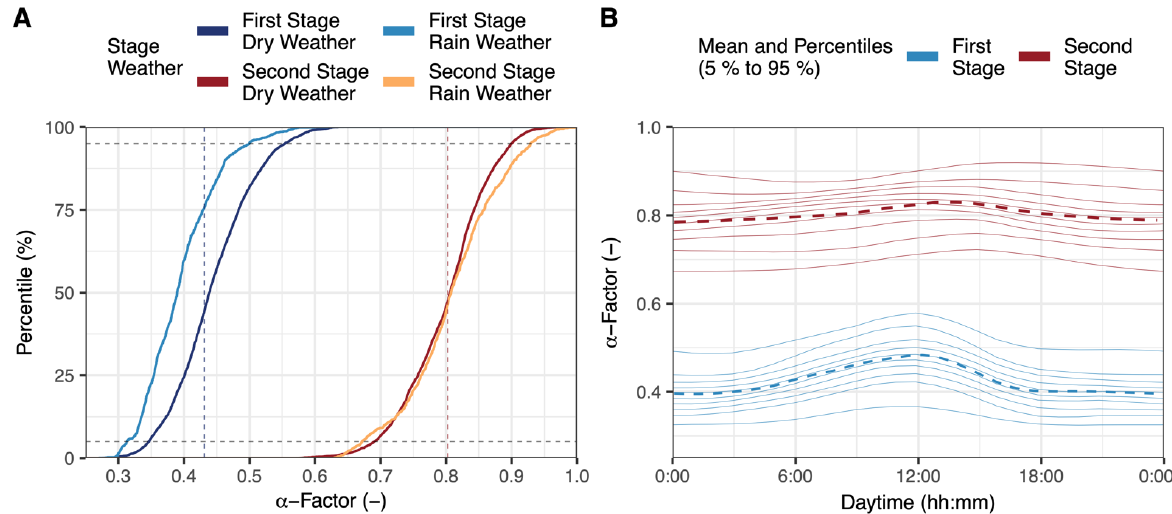
Figure 2. Empirical cumulative distribution ( A ) and diurnal variation ( B ) of α -factors as percentiles (solid lines) and means (dashed lines) in the examined two-stage AS WWTP.